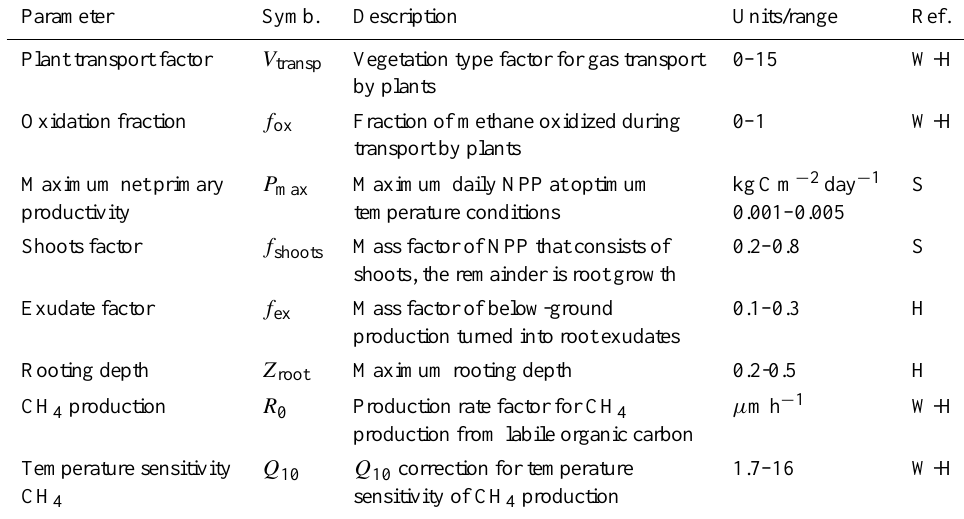
Table 2. Vegetation and microbial population parameters used in PEATLAND-VU and the model experiments described below. If no units are given in column Units/range, the parameter is dimensionless. Column Symb: symbols used for the parameters; Column Ref: literature references; W-H is Walter and Heimann (2000); S is Shaver et al. (1996); H is van Huissteden et al. (2009).